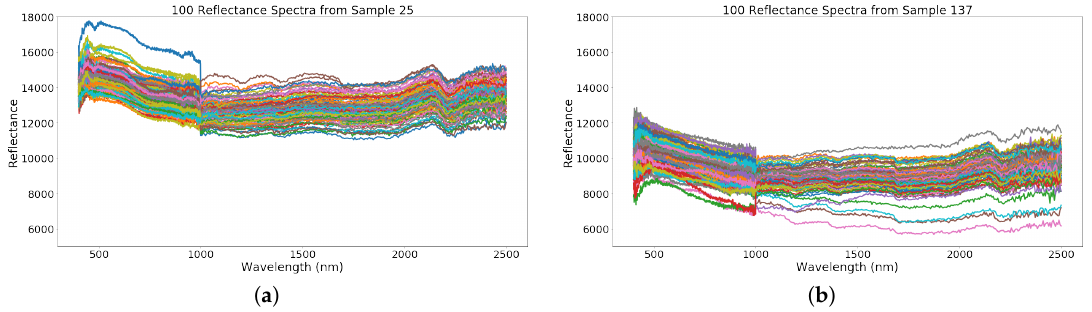
Figure 14. Examples of spectra in the available samples; 100 spectra randomly selected from ( a ) sample 25 and ( b ) sample 137. Colormap: random color for each